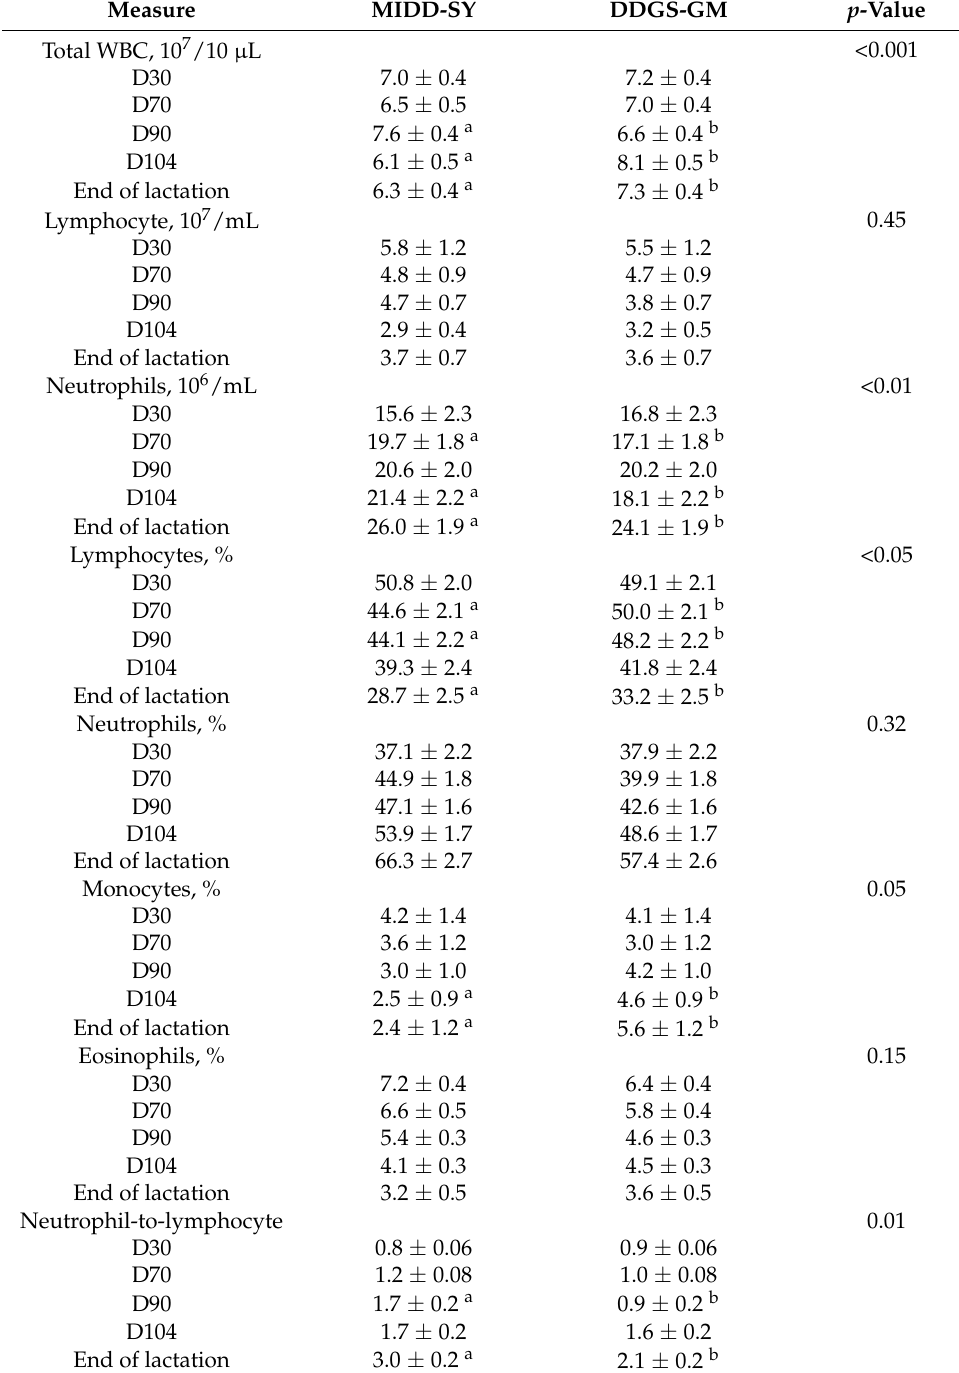
Table 4. Effects of diet by gestational day on total white blood cell counts and other descriptive leukocyte measures and neutrophil–to–lymphocyte ratio for sows at days 30, 70, 90, 104, and end of lactation 1